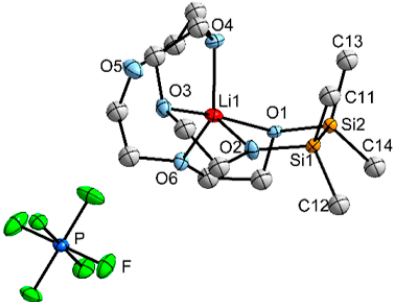
Figure 1. Molecular structure of [Li(1,2-disila[18]crown-6)]PF 6 ( 1 ) in the crystal. Thermal ellipsoids represent the 50% probability level. Hydrogen atoms are omitted for clarity. Selected bond lengths (pm) and angles (°): Si1–Si2: 235.1(1), Si1–O1: 168.9(2), Si2–O2: 167.9(2), Li1–O1: 224.8(5), Li1–O2: 200.4(5), Li1–O3: 212.1(5), Li1···O5: 295.7(5), Li1–O6: 194.9(5), O3–Li1–O1: 169.4(2), O2–Li1–O4: